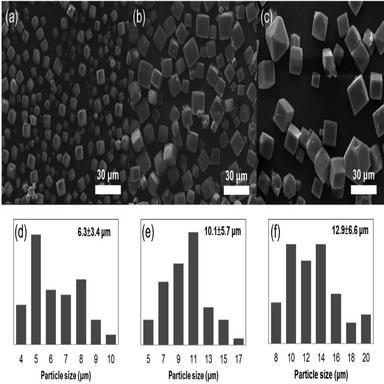
SEM images of Cr-embedded MOF-199 with de novo synthesis temperature of (a) 45 C, (b) 65 C, (c) 85 C. Particle size distribution was calculated from the SEM images and shows in (d), (e), and (f). Reprinted with permission from Ref..